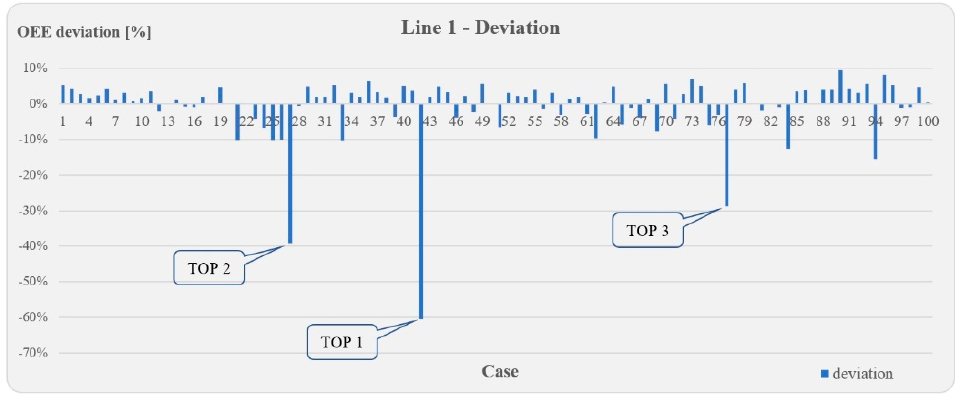
Figure 4. Deviation from the estimation for assembly line 1.